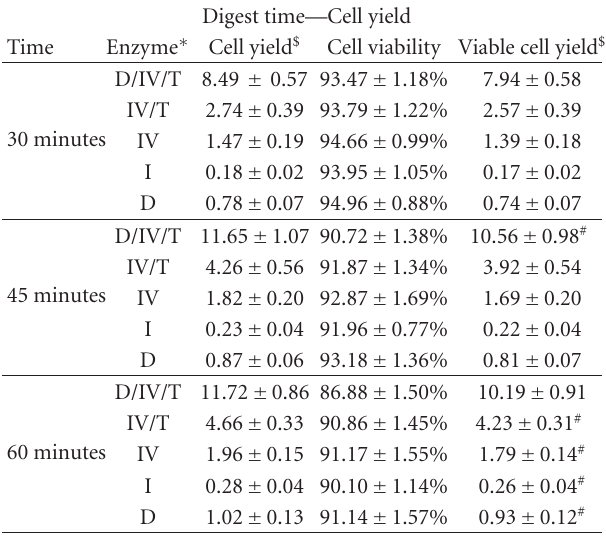
Table 1: Correlation between digest time and cell yield when di ff erent enzymes were used for brown adipose digest.